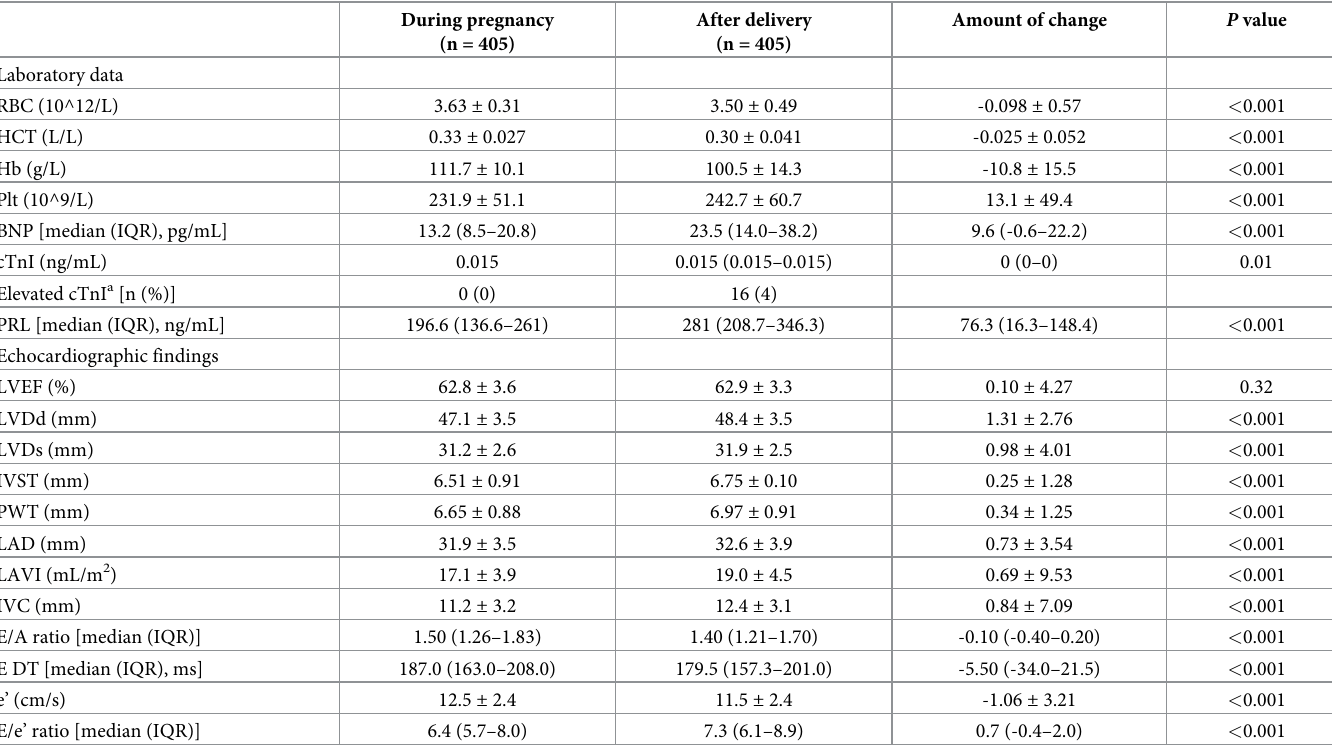
Table 2. Results of examinations during pregnancy and after delivery.